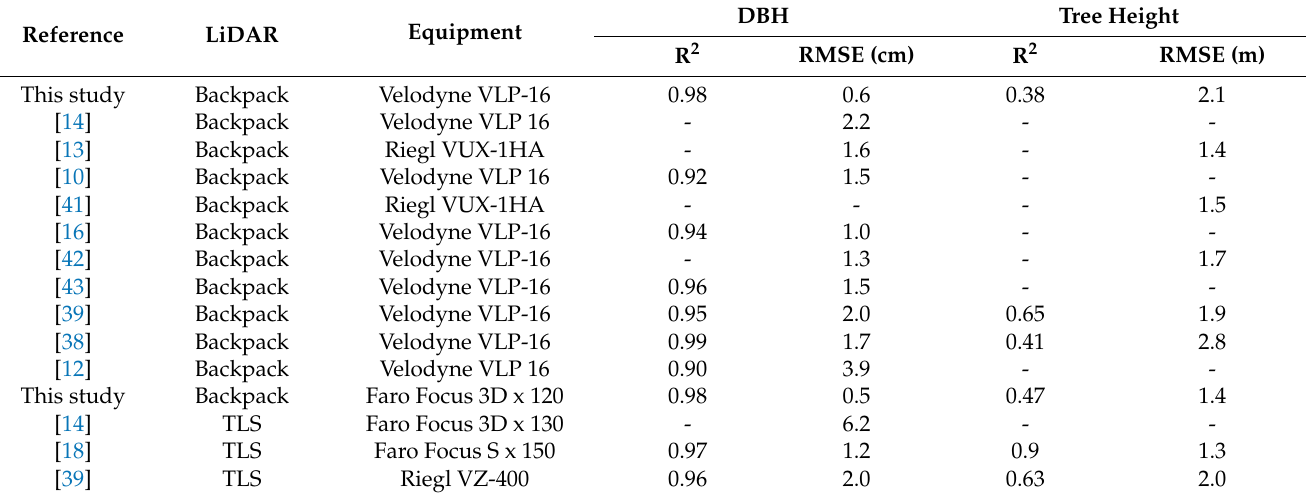
Table 6. Comparison of existing research results between backpack LiDAR and